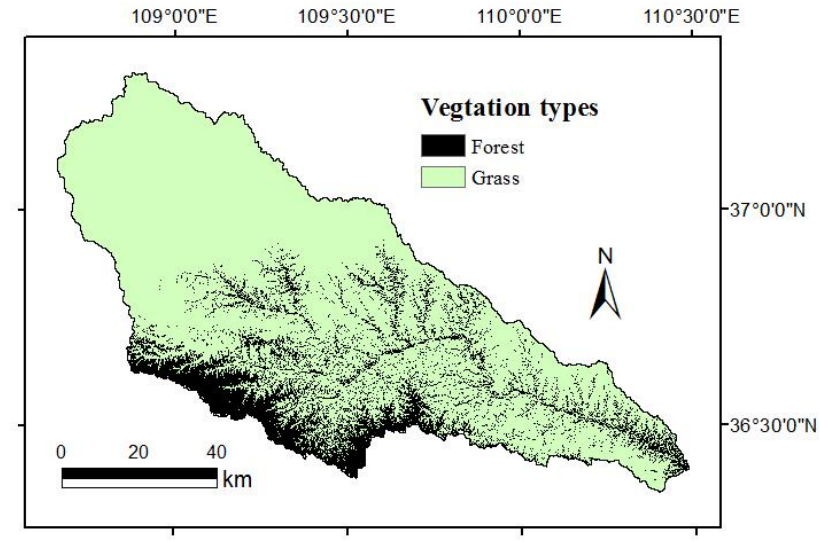
Figure 3. Predictive distribution of potential natural vegetation (PNV) in the Yanhe River catchment.